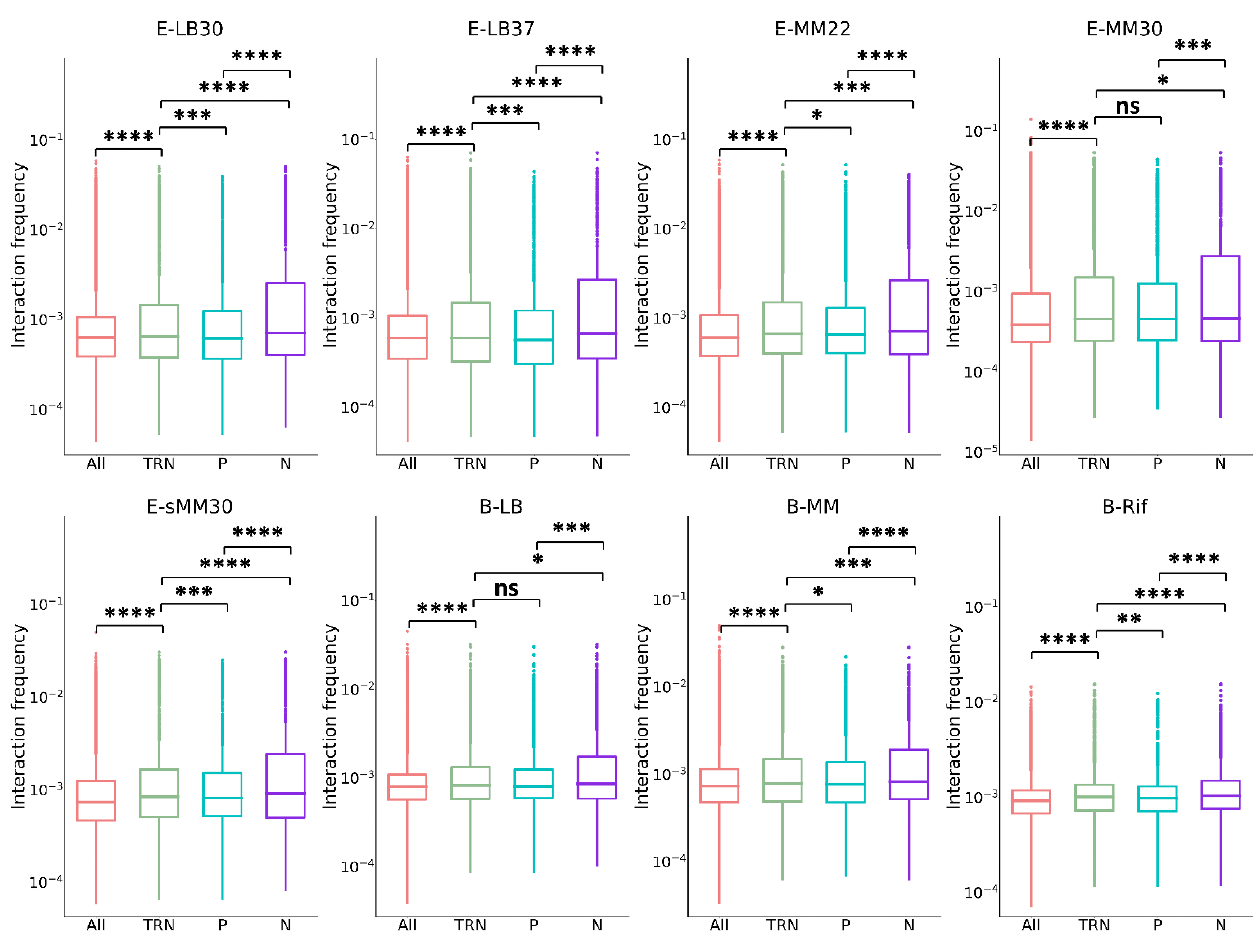
Figure 1. Comparison of chromatin interaction frequency in global TRN. Under almost all culture conditions, the chromatin interaction frequency within TRN (denoted as TRN) is significantly higher than that of all the gene pairs in the whole genome (denoted as All); the interaction frequency of positive regulation (denoted as P) is significantly lower than TRN; the interaction frequency of negative regulation (denoted as N) is significantly higher than TRN. The symbols on the figure indicate statistical significance levels: ns: p > 0.05; *: p ≤ 0.05; **: p ≤ 0.01; ***: p ≤ 0.001; ****: p ≤ 0.0001.